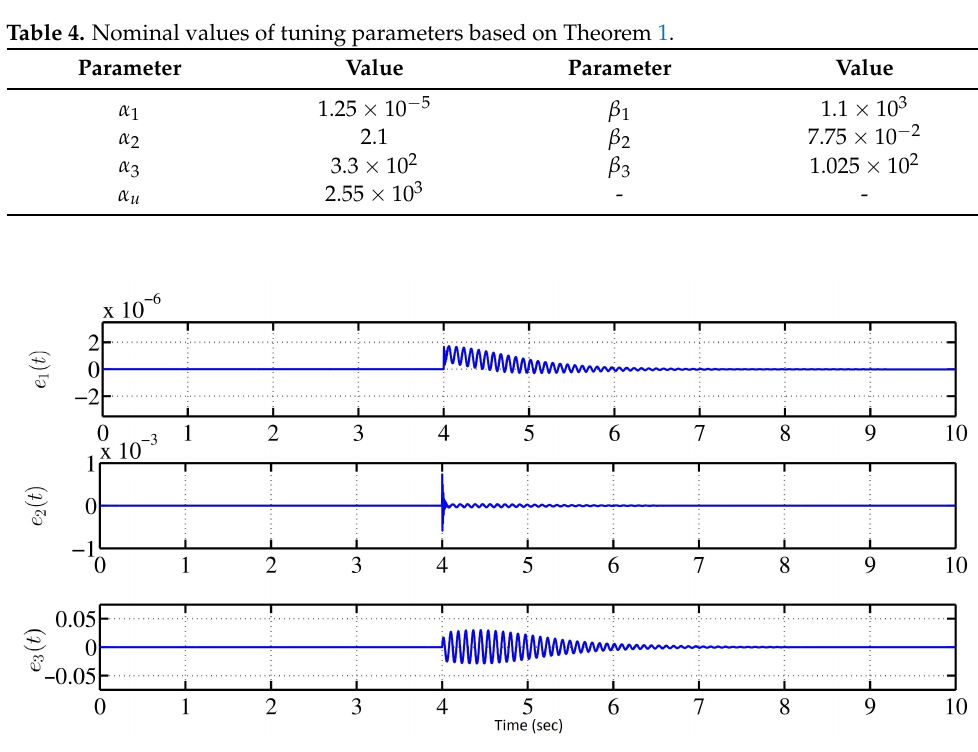
Figure 8. Response of tracking-errors under parametric uncertainties ( e i ( t ) , i =